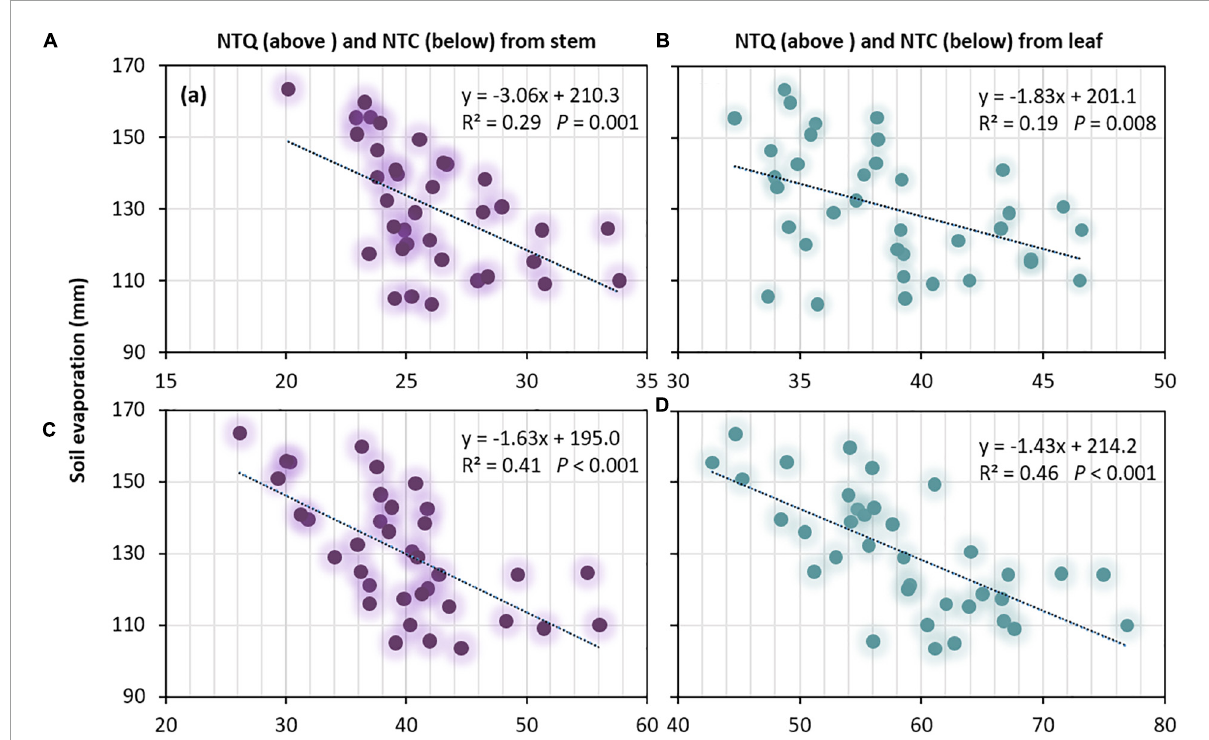
FIGURE5 Soil evaporation (SE) followed in a negative linear regression curve with the quantity of transferred N (NTQ) from (A) stem and (B) leaf and with a contribution of transferred N (NTC) from (C) stem and (D) leaf of spring wheat across 2019–2020.